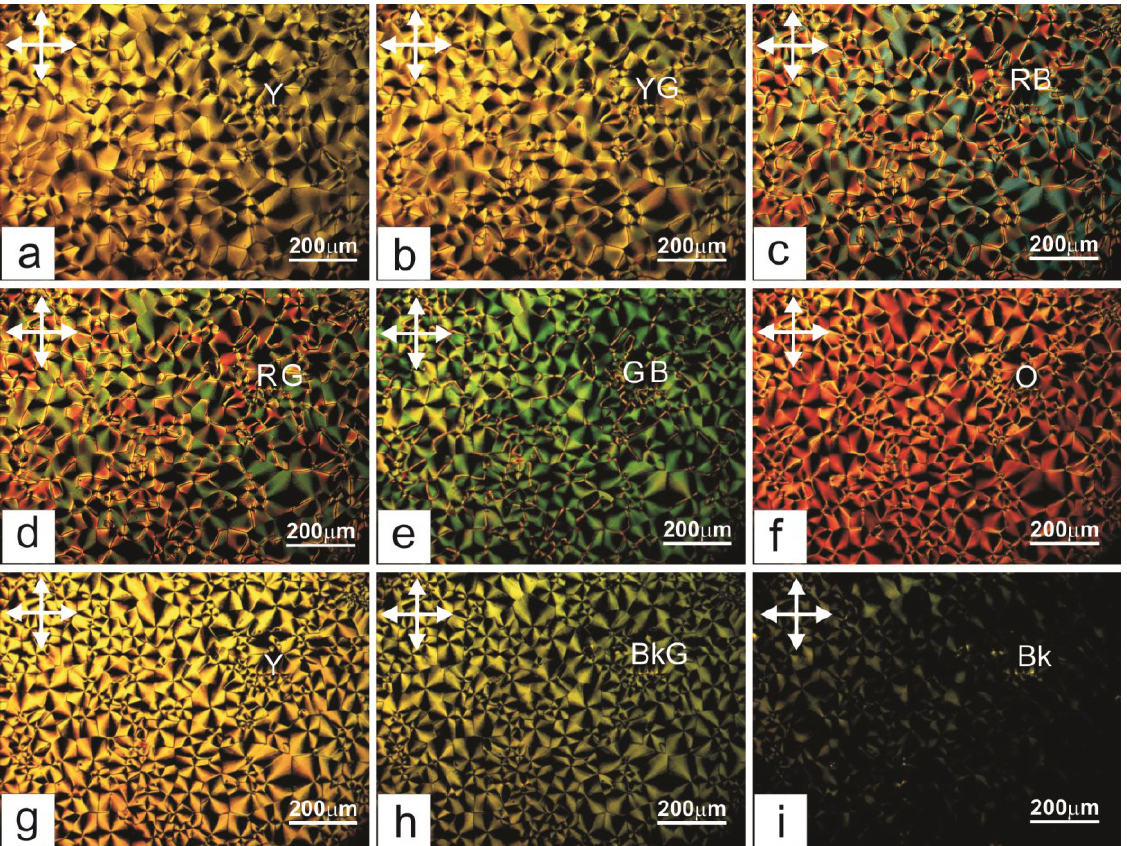
Figure 1. Microphotographs of domains in the 30 µm thick planar 5CB layer on the PC surface at applied voltages U of ( а ) 1.1; ( b ) 1.2; ( c ) 1.9; ( d ) 2.2; ( e ) 2.8; ( f ) 5; ( g ) 7; ( h ) 16, and ( i ) 30 V. Texture colors in an electric field are marked with characters Y (yellow), G (green), B (blue), R (red), О (orange), and Bk (black). Arrows show the polarization